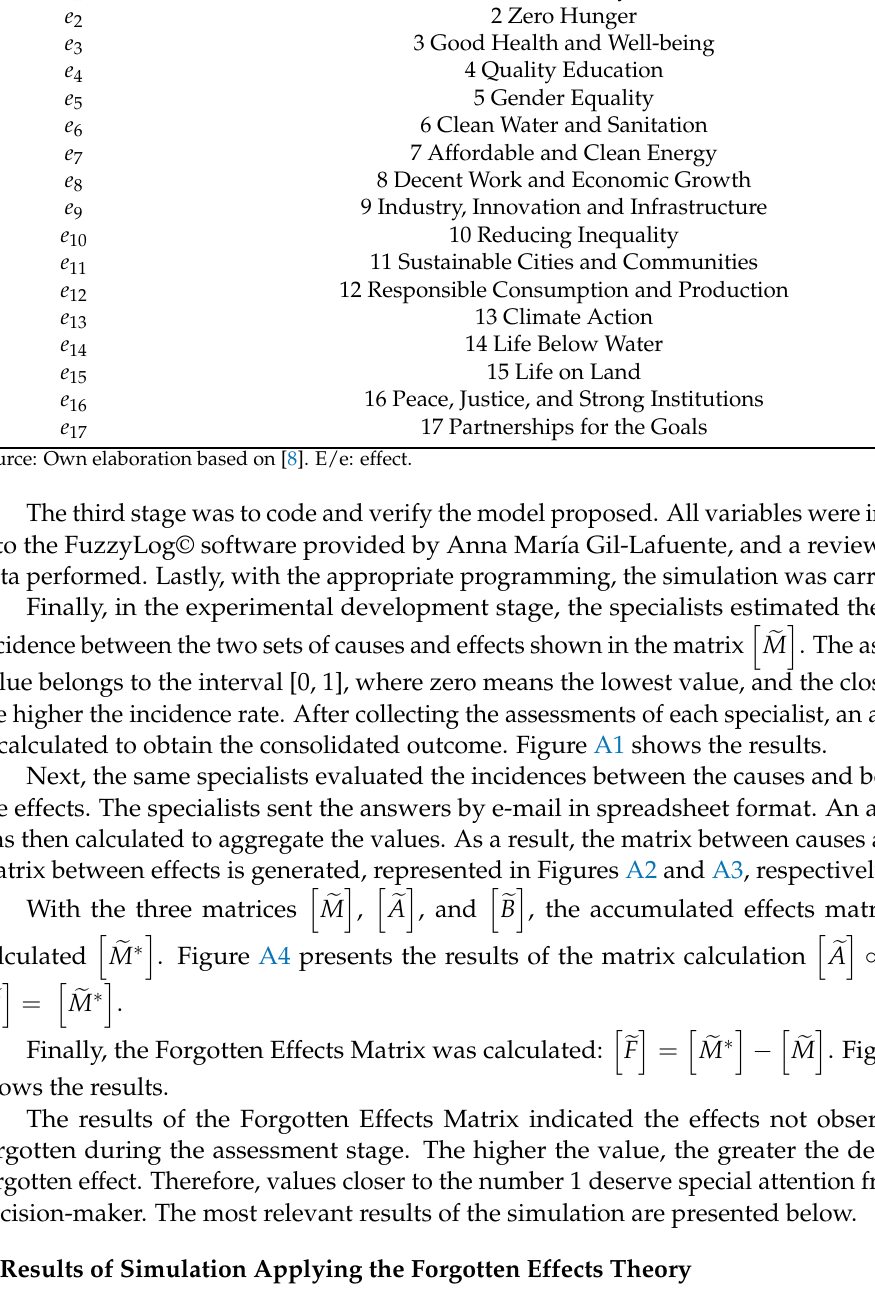
Table 2. The 17 Sustainable Development Goals. E SDGs e